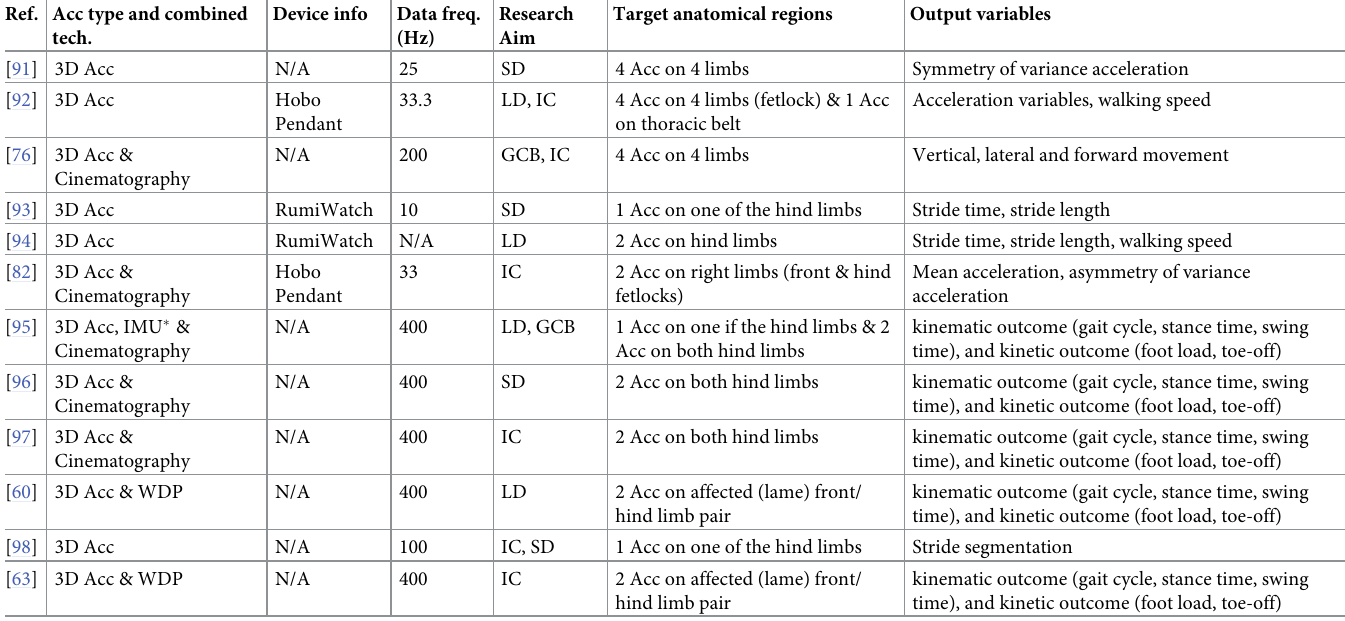
� IMU is a device that integrates 3D accelerometers, 3D gyroscopes, and a